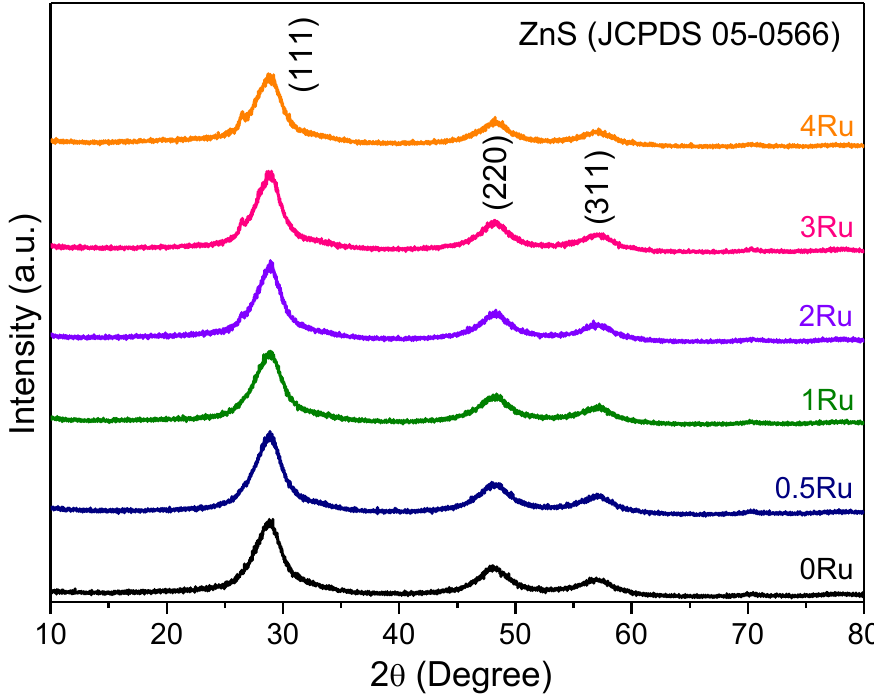
Catalysts 2020 , 10 , x FOR PEER REVIEW Figure 2. XRD patterns of ruthenium-doped CZS / MSG heterostructured photocatalysts. Figure 2. XRD patterns of ruthenium-doped CZS/MSG heterostructured photocatalysts. Table 1. Summary of average crystallite size D 111 , particle size distribution D 50 , BET, and photocurrent of as-synthesized CZS/MSG heterostructured photocatalysts with different amounts of ruthenium.